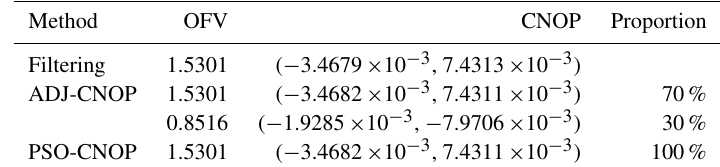
Table 2. Same as Table 1, except at 13 (cid:49)t .